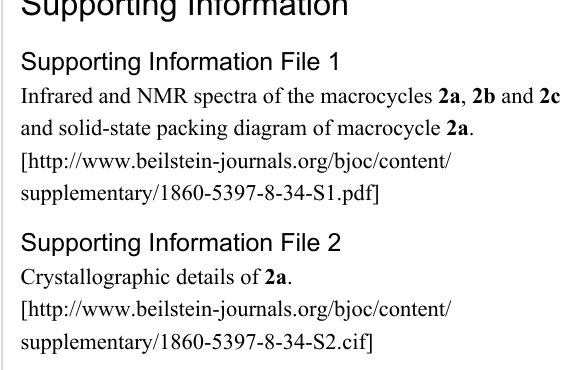
X-ray data collection and structure refinements: Crystallo- graphic data for 2a were collected on a Bruker SMART